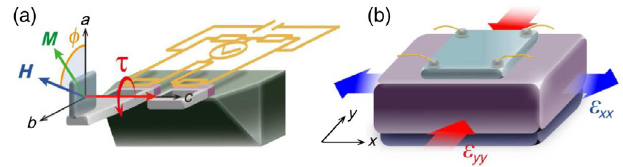
FIG. 6. (a) Experimental setup of in-plane magnetic torque measurements. Magnetic torque τ ¼ μ 0 V H × M is detected by a microcantilever. Here, H is rotated within the ab plane. (b) Ex- perimental setup of elastoresistance measurements. The sample (light blue) is glued on the piezo stack (purple), and the resistances R and R along the x and y directions, respectively, xx yy are measured by the van der Pauw method. The strain ε along x xx is measured by a strain gauge attached on the back side of the piezo stack. The strain ε along y is calculated by the yy temperature-dependent Poisson ratio, which has been calibrated in